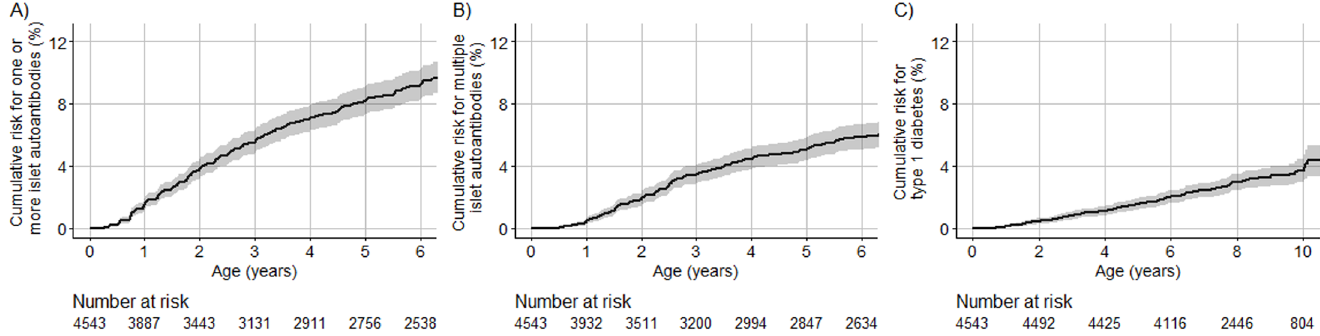
Fig 2. Cumulative risks of 1 or more islet autoantibody, multiple islet autoantibody, and type 1 diabetes in TEDDY children with the HLA DR3/DR4-DQ8 or DR4-DQ8/DR4-DQ8 genotype. The cumulative risk for 1 or more islet autoantibodies (A), multiple islet autoantibodies (B), and type 1 diabetes (C) for TEDDY children ( y- axis) is shown relative to the age of the children ( x- axis) and was calculated using the Kaplan–Meier method. The shaded area represents the 95% confidence interval of the cumulative risk. The numbers at risk indicate the number of children included in the analysis at each age.